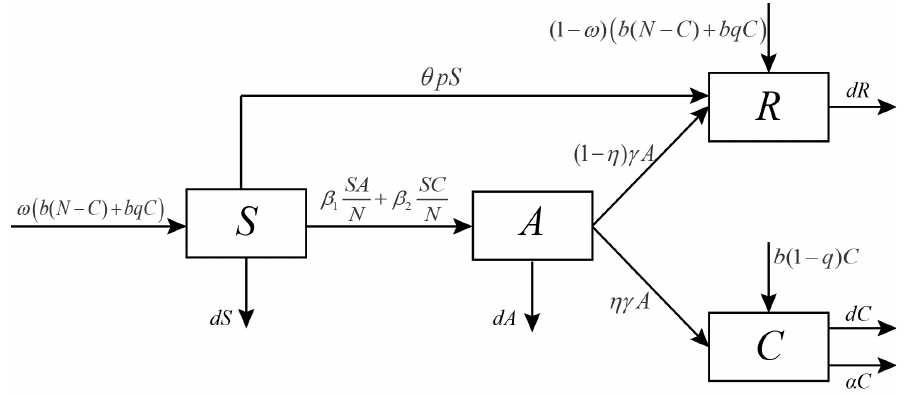
Fig 1. Schematic diagram of HBV transmission, structured. S ( t ), A ( t ), C ( t ) and R ( t ) represent susceptible, acute infection, chronic HBV carrier and recovered individuals,